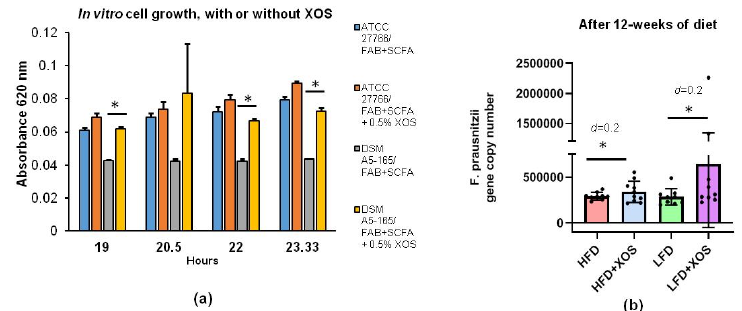
Figure 1. Xylo-oligosaccharides (XOS) increased the growth of F. prausnitzii in vitro and in vivo. ( a ) In vitro stimulation of F. prausnitzii growth with XOS. Cultivations of F. prausnitzii were done in fastidious anaerobe broth (FAB) supplemented with short-chain fatty acids (SCFA) in an anaerobic workstation. Ten mL cultures of commercially available F. prausnitzii strains American type of culture collections (ATCC) ® -27766 ™ and Deutsche Sammlung von Mikroorganismen und Zellkulturen GmbH (DSM) A2-165 were supplemented or not with XOS as 0.5% ( w / v %). The growth of F. prausnitzii was determined by following changes in the optical density at 620 nm. n = 4 replicates / treatments. * indicates statistically significant di ff erence between the groups; ( b ) Quantitative real-time PCR of